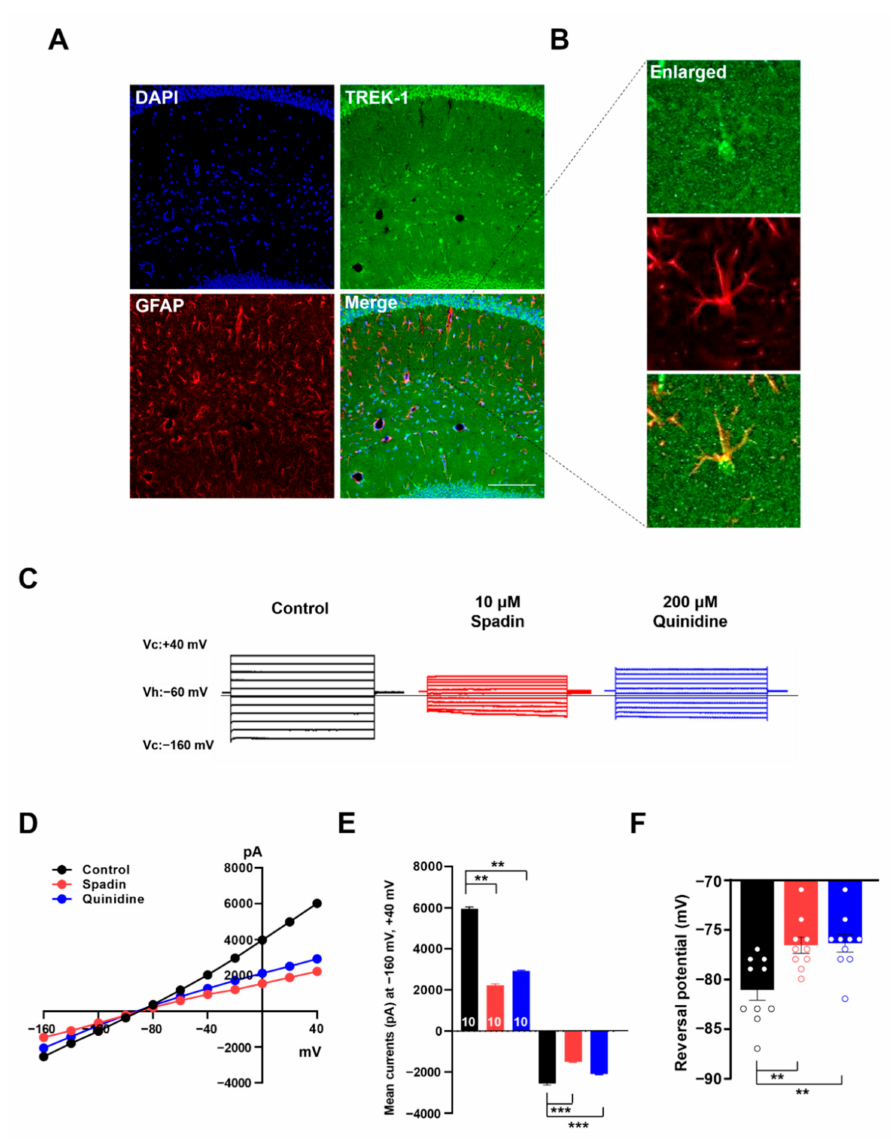
Figure 6. Spadin e ffi ciently controls astrocytic passive conductance in hippocampus. ( A , B ) Representative fluorescence images of dual immunostaining of TREK-1 (green) and GFAP (red), with DAPI staining of astrocyte nuclei (blue) in mouse hippocampus. The images show that TREK-1 was highly expressed in astrocytes. Scale bar, 150 µ m. ( C ) Representative traces of passive conductance induced by voltage stepping from − 160 mV to + 40 mV in hippocampal astrocytes treated with vehicle (black), 10 µ M spadin (red) or 200 µ M quinidine (blue) respectively. ( D ) Current–voltage ( I – V) curves of passive conductance in ( C ). ( E , F ) Bar graphs showing averaged currents at − 160 mV and + 40 mV of holding potentials ( E ) and reversal potentials (Vrev) ( F ), respectively. The number on each bar indicates n for each condition. All values are mean ± s.e.m. p -values were obtained with one-way ANOVA followed by Turkey’s post hoc test. ** p < 0.01 and *** p <